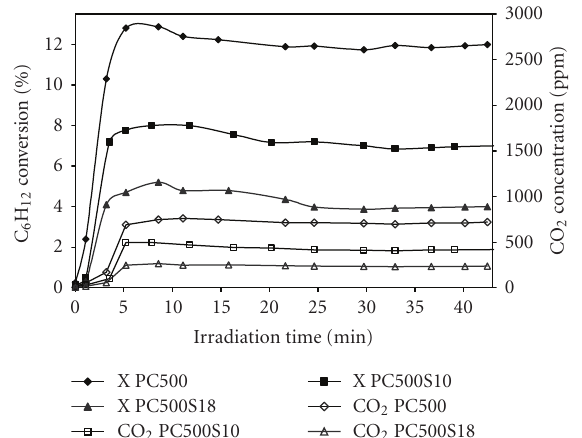
Figure 5: Cyclohexane conversion (X) and CO 2 outlet concentra- tion (CO 2 ) as a function of irradiation time on PC500, PC500S10, and PC500S18.